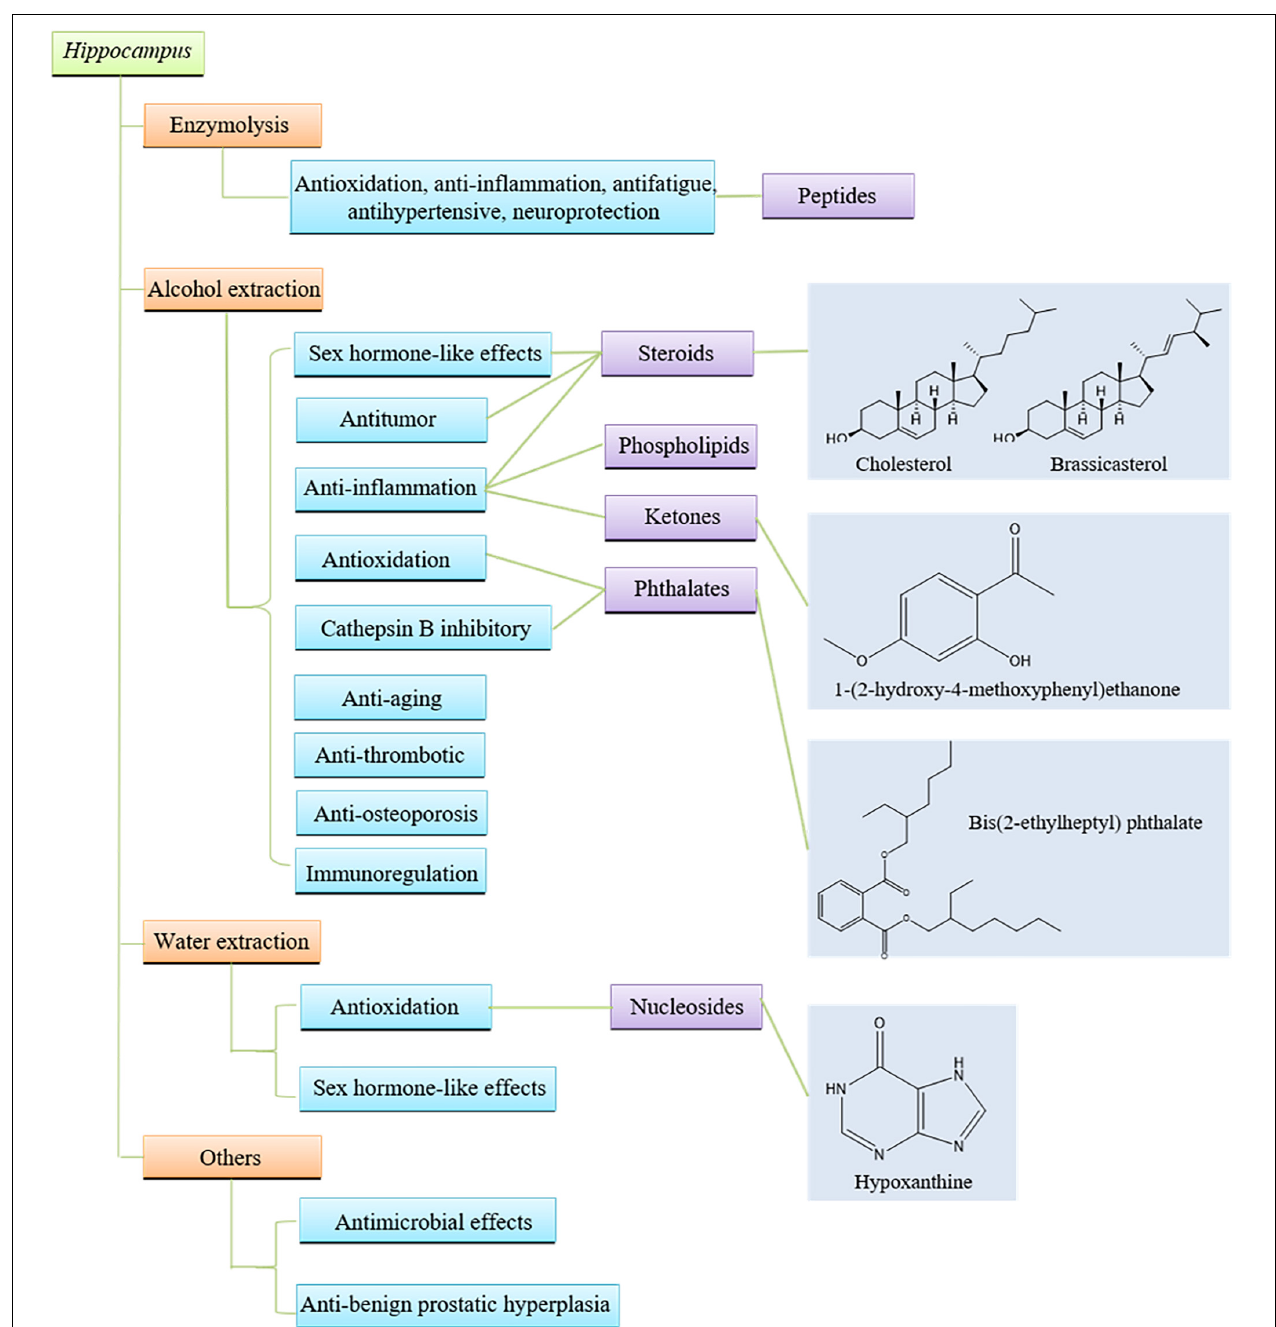
FIGURE 6 | Pharmacological activities of Hippocampus extractions.